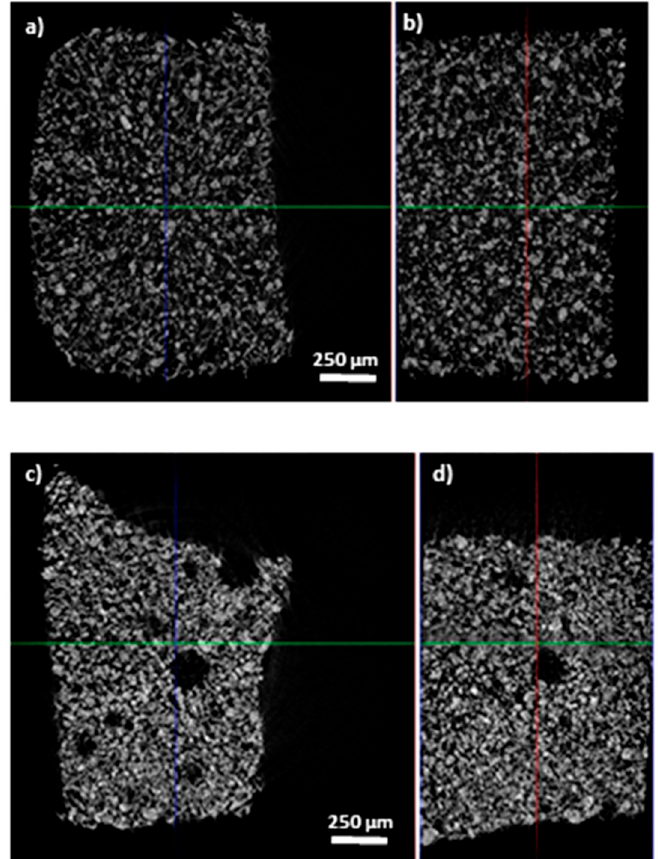
Figure 4. 2D cut view of the MRE composite with ( a , b ) isotropic filler distribution shows homogenous 125 structure without any porosity (elastomers A and B); ( c , d ) anisotropic distribution shows more voids 126 due to magnetic field (elastomers A and B). 127